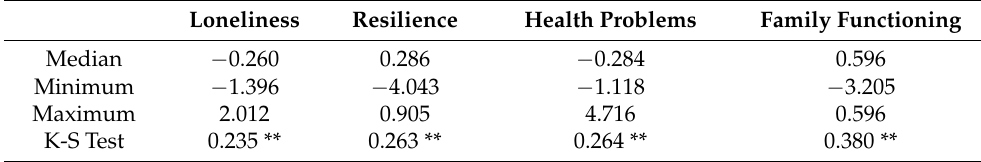
Table 3. Descriptive statistics for latent variables.